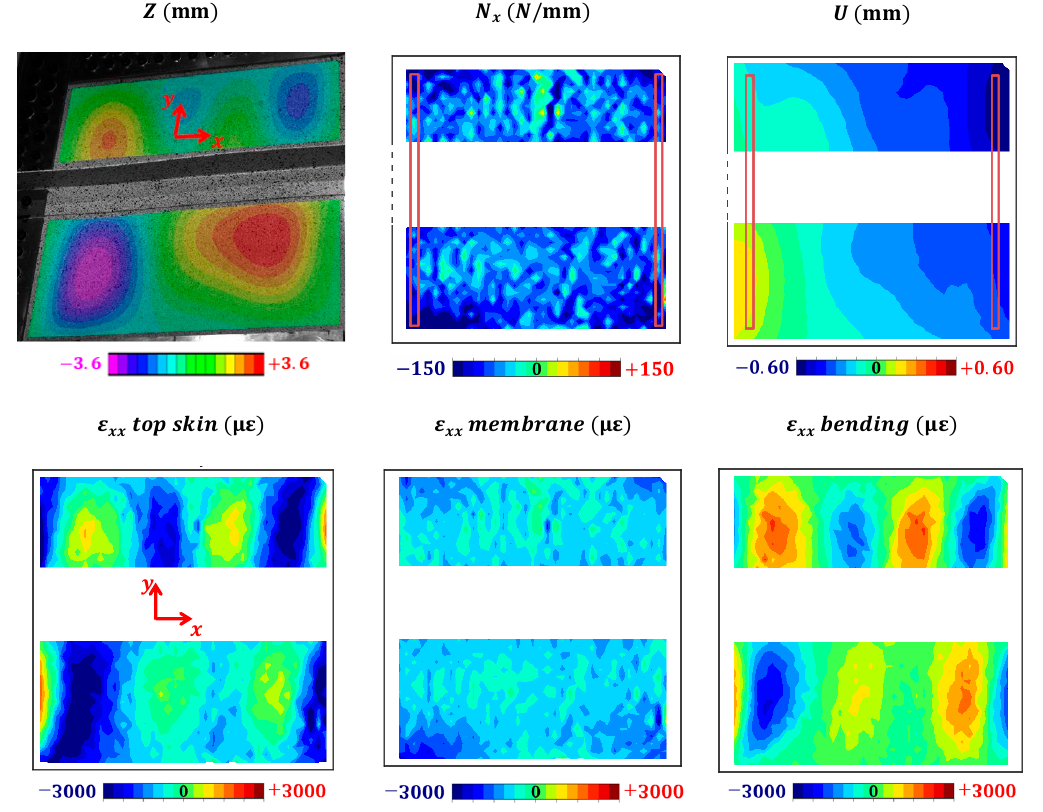
Figure 23. Fields computed ( N x force flux, ε xx membrane and bending) from the fields measured (positions, displacements, ε xx top skin)—Sample1 just before